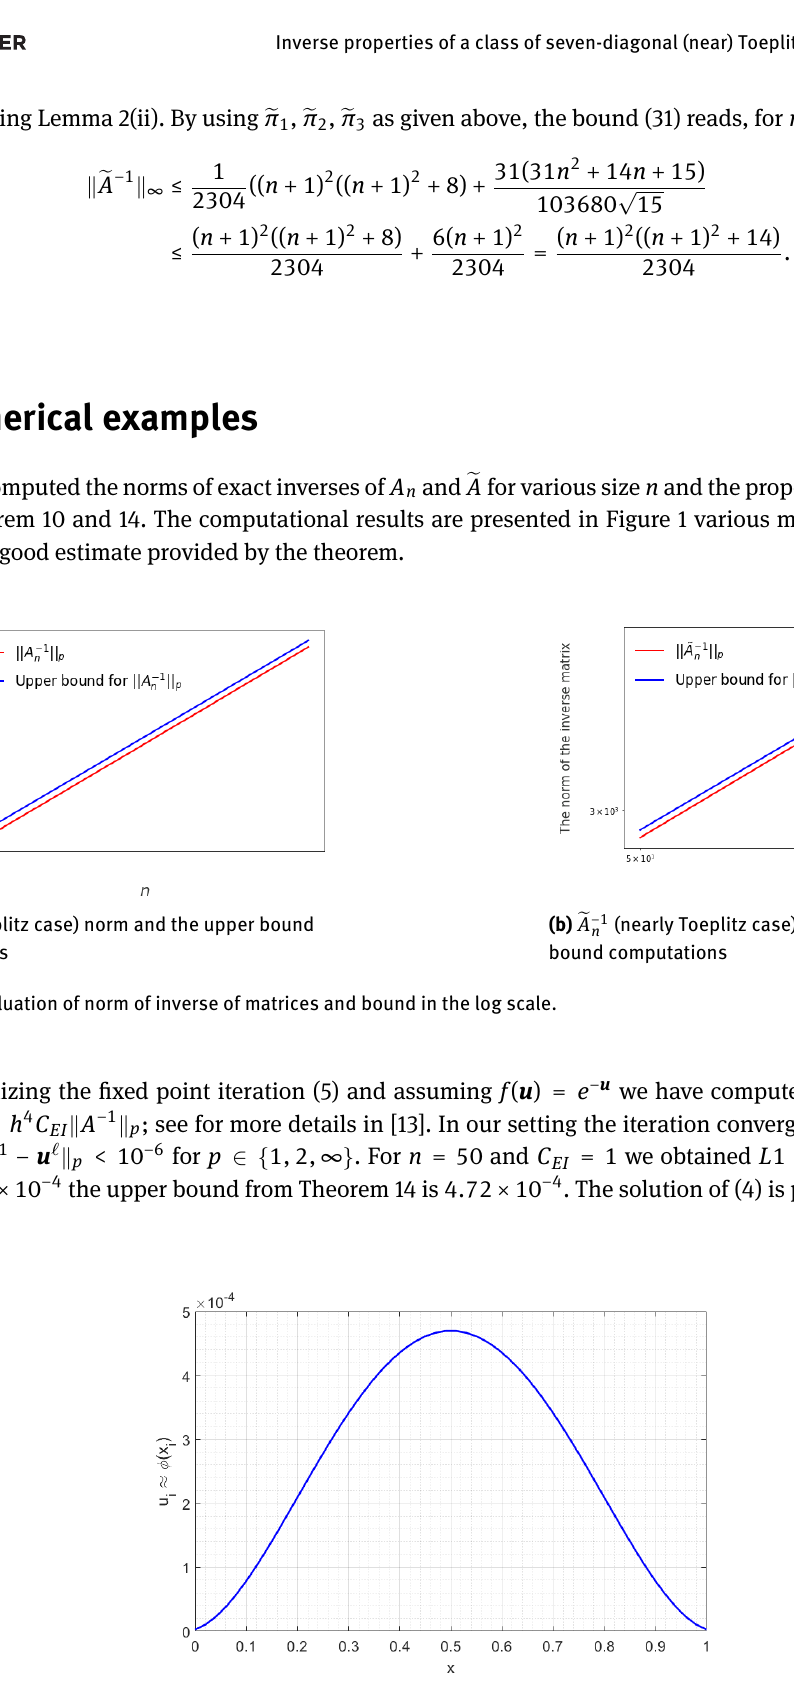
Figure 2: The solution of (4) is presented in blue for n = 50 and C EI = 1